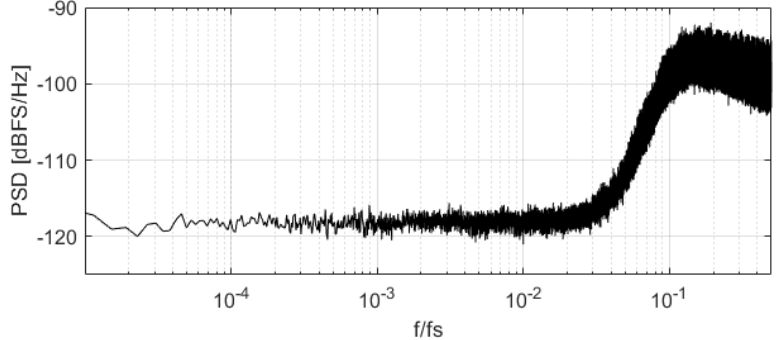
Figure 16. PSD of the loop filter linearity error when the input signal is in a NP region.